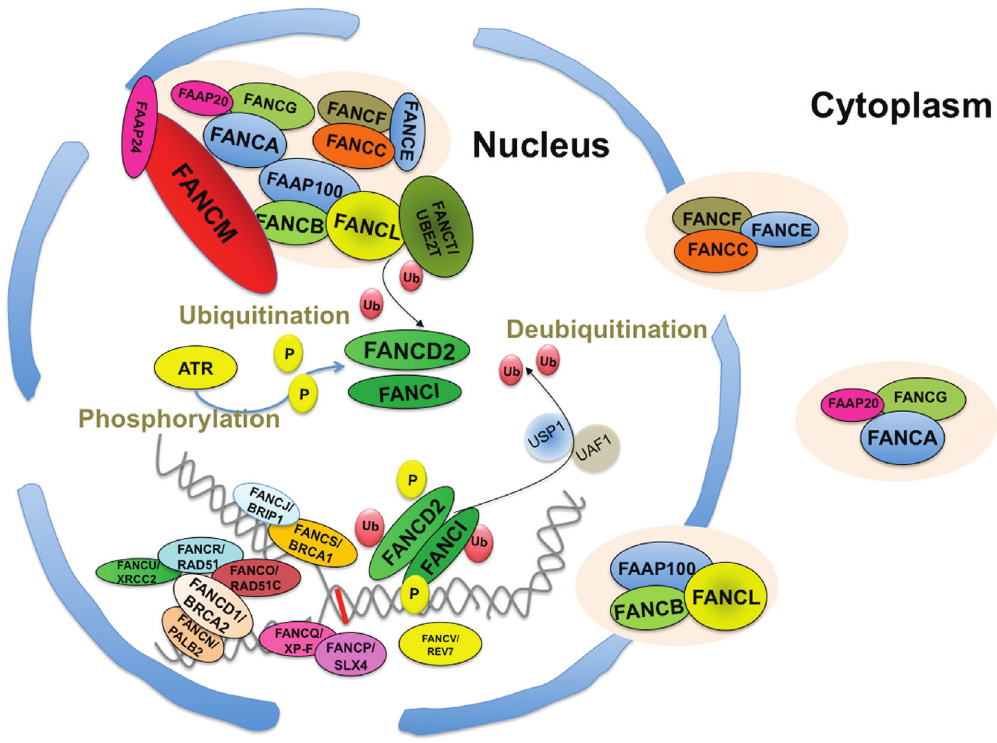
Figure1 -SchematicrepresentationofthesubcellulardistributionoftheFANCproteins,theirassociationandtheirrelocalizationinnuclearfociatstalled replication forks. In unstressed conditions, three subcomplexes are present in the nucleus and/or the cytosol: FANCA, FANCG and FAAP20; FANCC, FANCE and FANCF; and FANCB, FANCL and FAAP100. In the presence of DNA damage (the red line represents an interstrand crosslink) that leads to stalledreplicationforks,alltheFANCproteinsshuttleintothenucleustoformtheFANCcorecomplextomonoubiquitinateFANCD2andFANCI,which in turn assemble to subnuclear foci, where they colocalize with several other proteins involved in homologous recombination, including other FANC and FANC-like representatives. The USP1:UAF1 dimer deubiquitinates both FANCD2 and